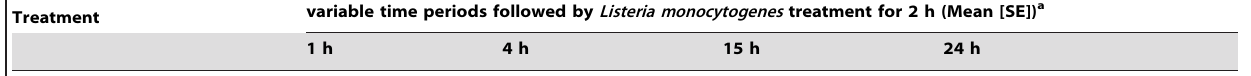
Table 2. Tight junction integrity analysis with Dextran FITC permeability assays.